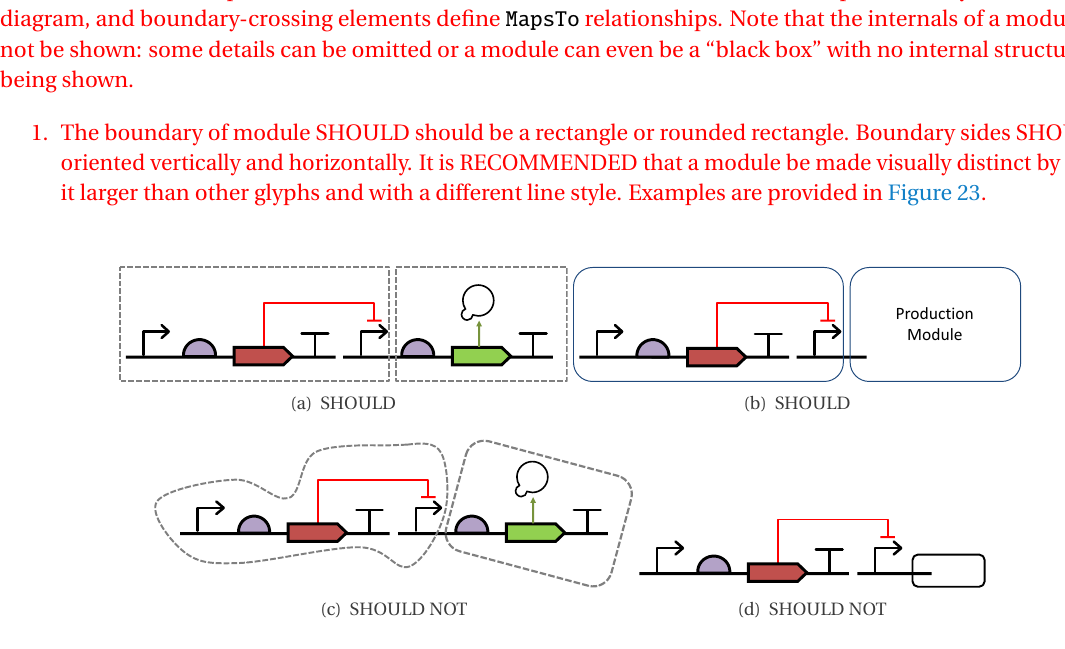
2. An undirected edge (i.e., having no “arrow head”) that crosses the boundary of a module represents a mapping